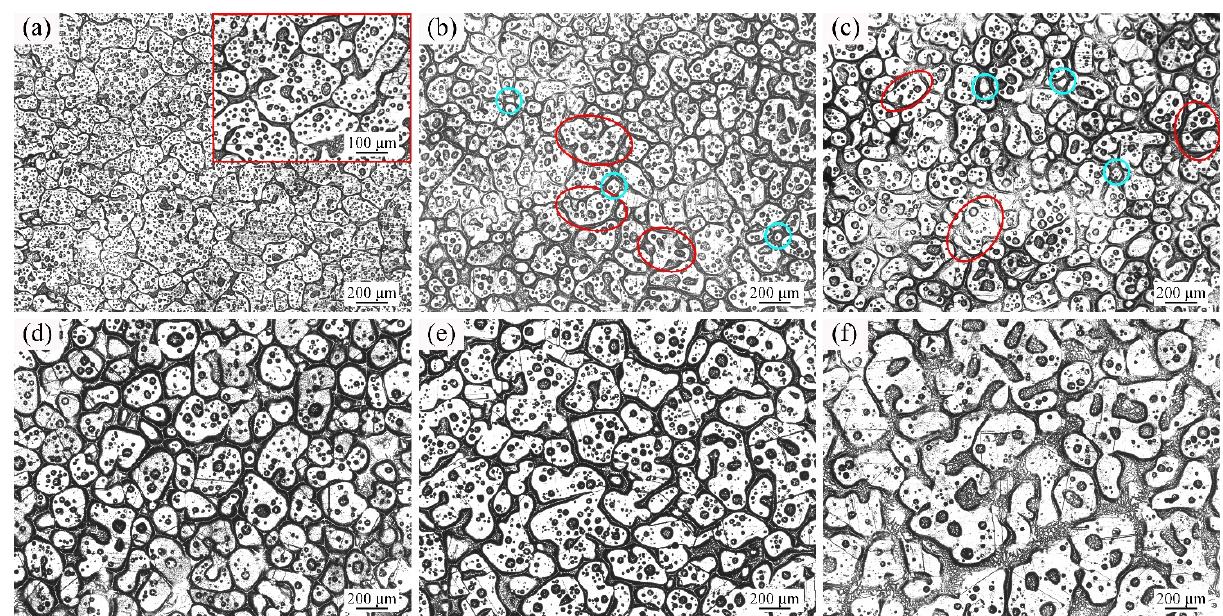
Figure 6. Optical micrographs of GH3536 alloy heat treated at 1367 °C for ( a ) 5 min, ( b ) 15 min, ( c ) 30 min, ( d ) 60 min, ( e ) 90 min, and ( f ) 120 min.